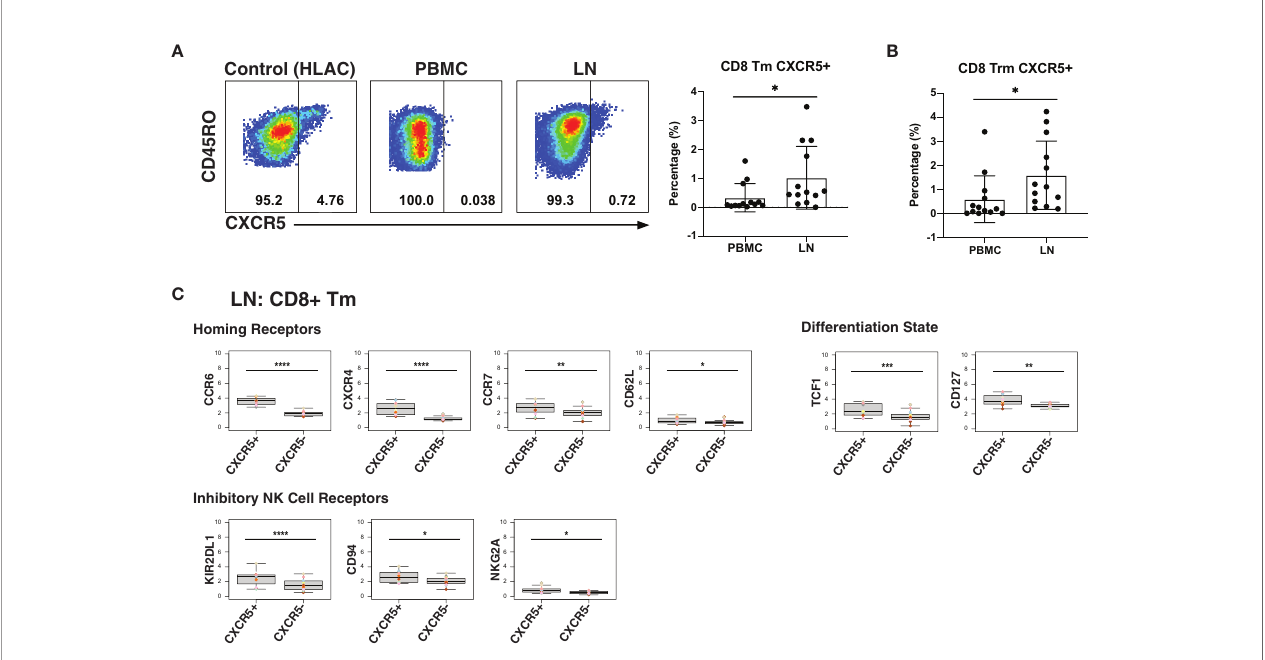
FIGURE 4 | LNs from PLWH are enriched for CXCR5+ CD8+ T cells expressing high levels of inhibitory NK cell receptors. (A) CXCR5+ memory T cells are more frequent in LNs than in blood. Gating strategy (left) and frequencies of CXCR5+ cells (right) among memory CD8+ T cells from paired PBMCs and LNs. The gating strategy for CXCR5+ cells was established using human lymphoid aggregate cultures (HLAC) of tonsils, which harbor a distinct population of these cells. (B) CXCR5+ tissue-resident memory T cells (Trm) are more frequent in LNs than in blood. (C) Lymphoid CXCR5+ memory CD8+ T cells express higher levels of tissue homing receptors, markers of long-lived memory cells, and inhibitory NK receptors, relative to their CXCR5- counterparts. Shown are MSIs of the indicated homing receptors, differentiation state markers, inhibitory and activating NK cell receptors. *p<0.05, **p<0.01, ***p<0.001, ****p<0.0001 as assessed using the Student ’ s paired t test and adjusted for multiple testing using the Benjamini-Hochberg for